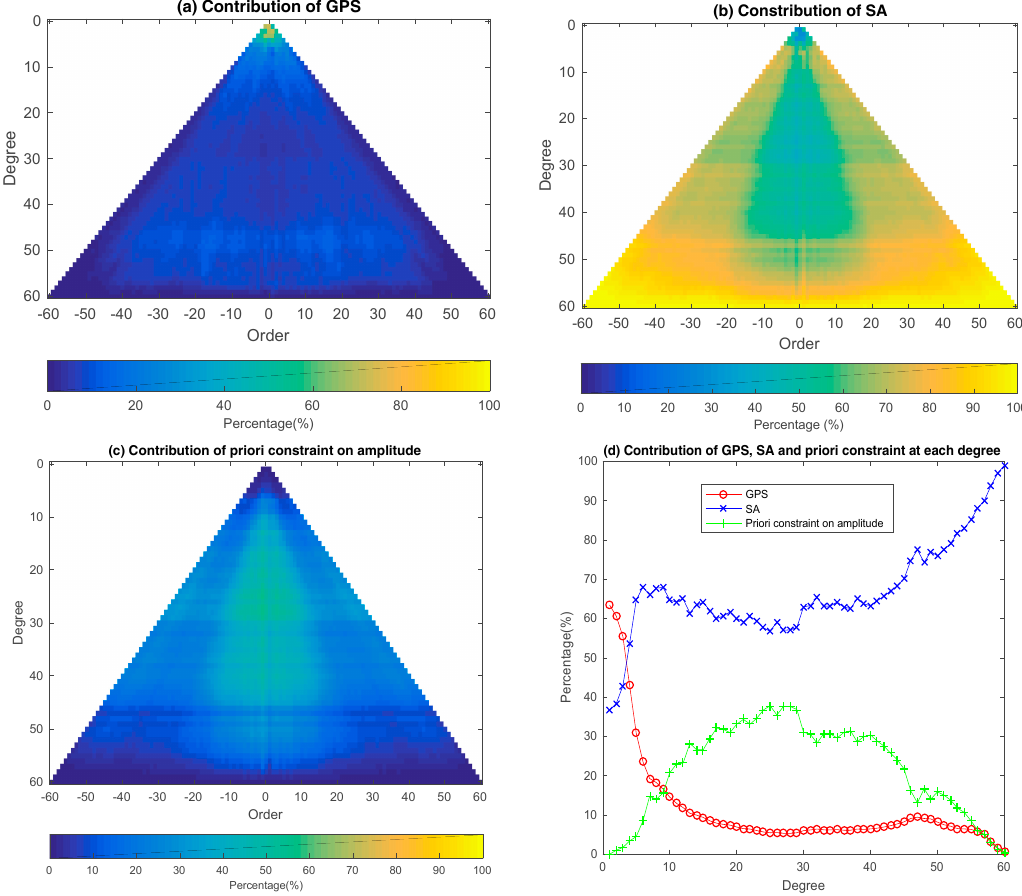
Figure 15. Contributions of each data set in the joining inversion for Stoke’s coefficients. ( a ) GPS site displacement contribution to each Stoke’s coefficient; ( b ) Satellite altimetry (SA) contribution to each Stoke’s coefficient; ( c ) Contribution of a priori constraint on the amplitudes to each Stoke’s coefficient; ( d ) GPS, SA and a priori constraint contribution at each degree of Stoke’s coefficients. Positive orders are for the cosine coefficients and negative orders are for the sine coefficients in ( a – c ).